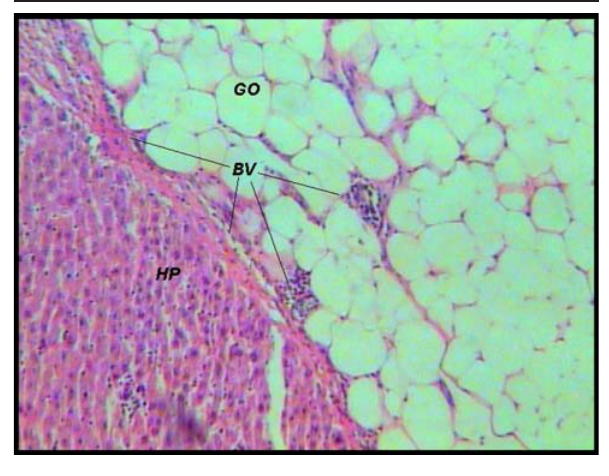
FIGURE 4 - Photomicrography of the omentum-hepatic region showing the presence of blood vessels ( BV ) of the greater omentum ( GO ) on the hepatic parenchyma ( HP ). Group with simultaneous HA and PVRB ligation and omental transposition at POD 90, HE, 50x